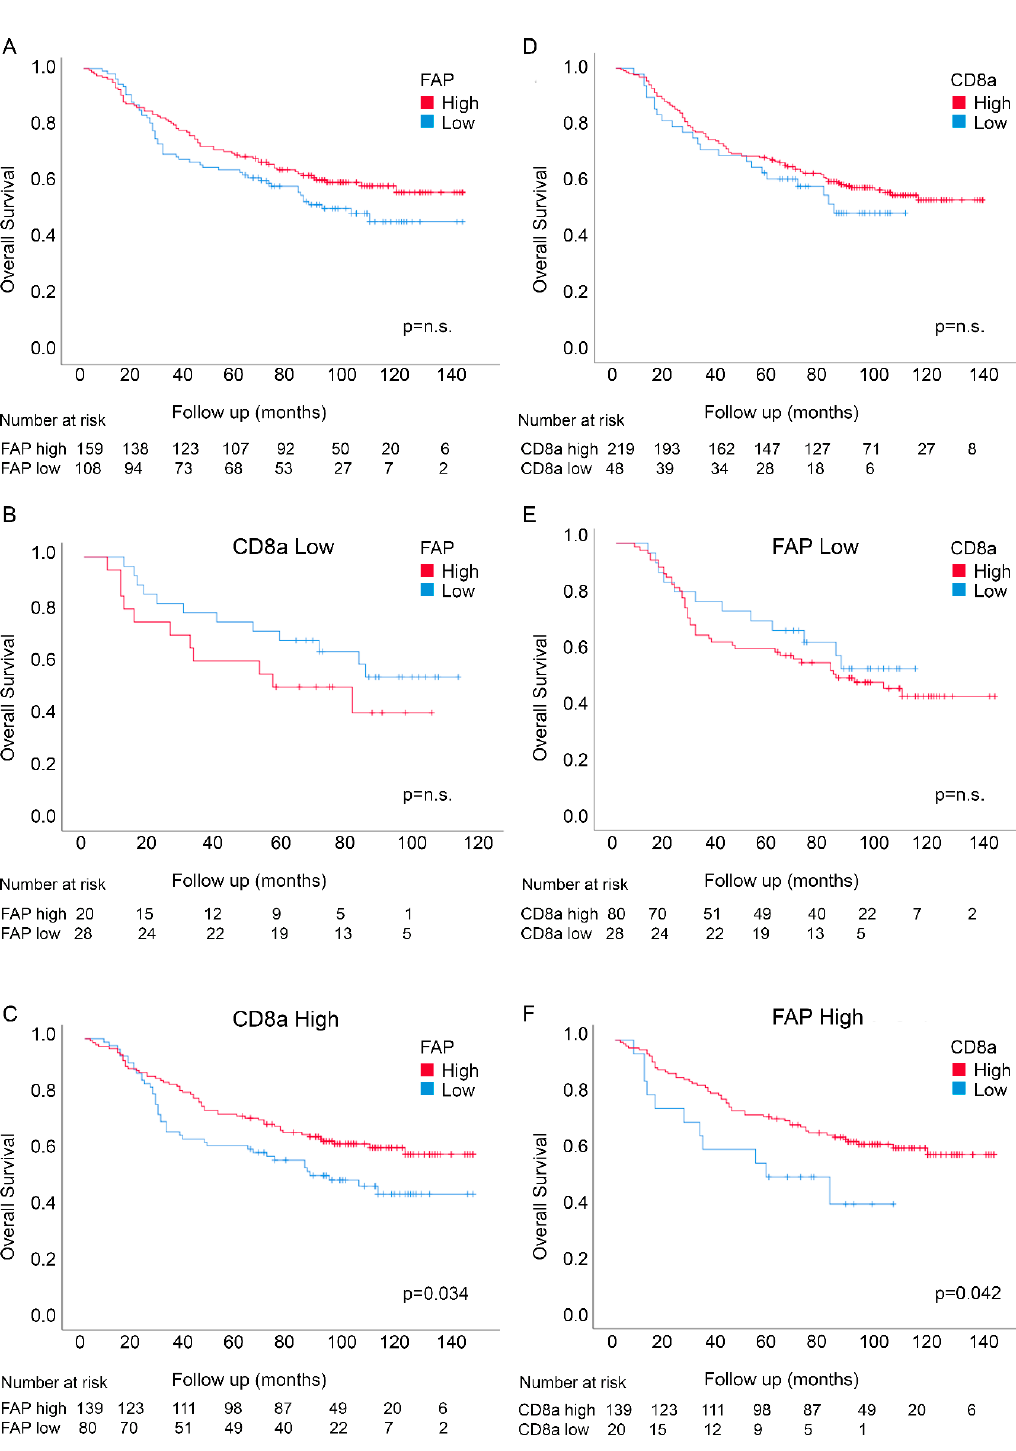
Figure 3. Overall survival according to FAP intensity in fibroblasts ( A ) and CD8a density ( D ) in the tumor center in the Nordic adjuvant trial. Overall survival for FAP intensity in patients expressing low levels of CD8a density ( B ) and high levels of CD8a density ( C ) and for CD8a density in patients expressing low levels of FAP intensity ( E ) and high levels of FAP intensity ( F ).